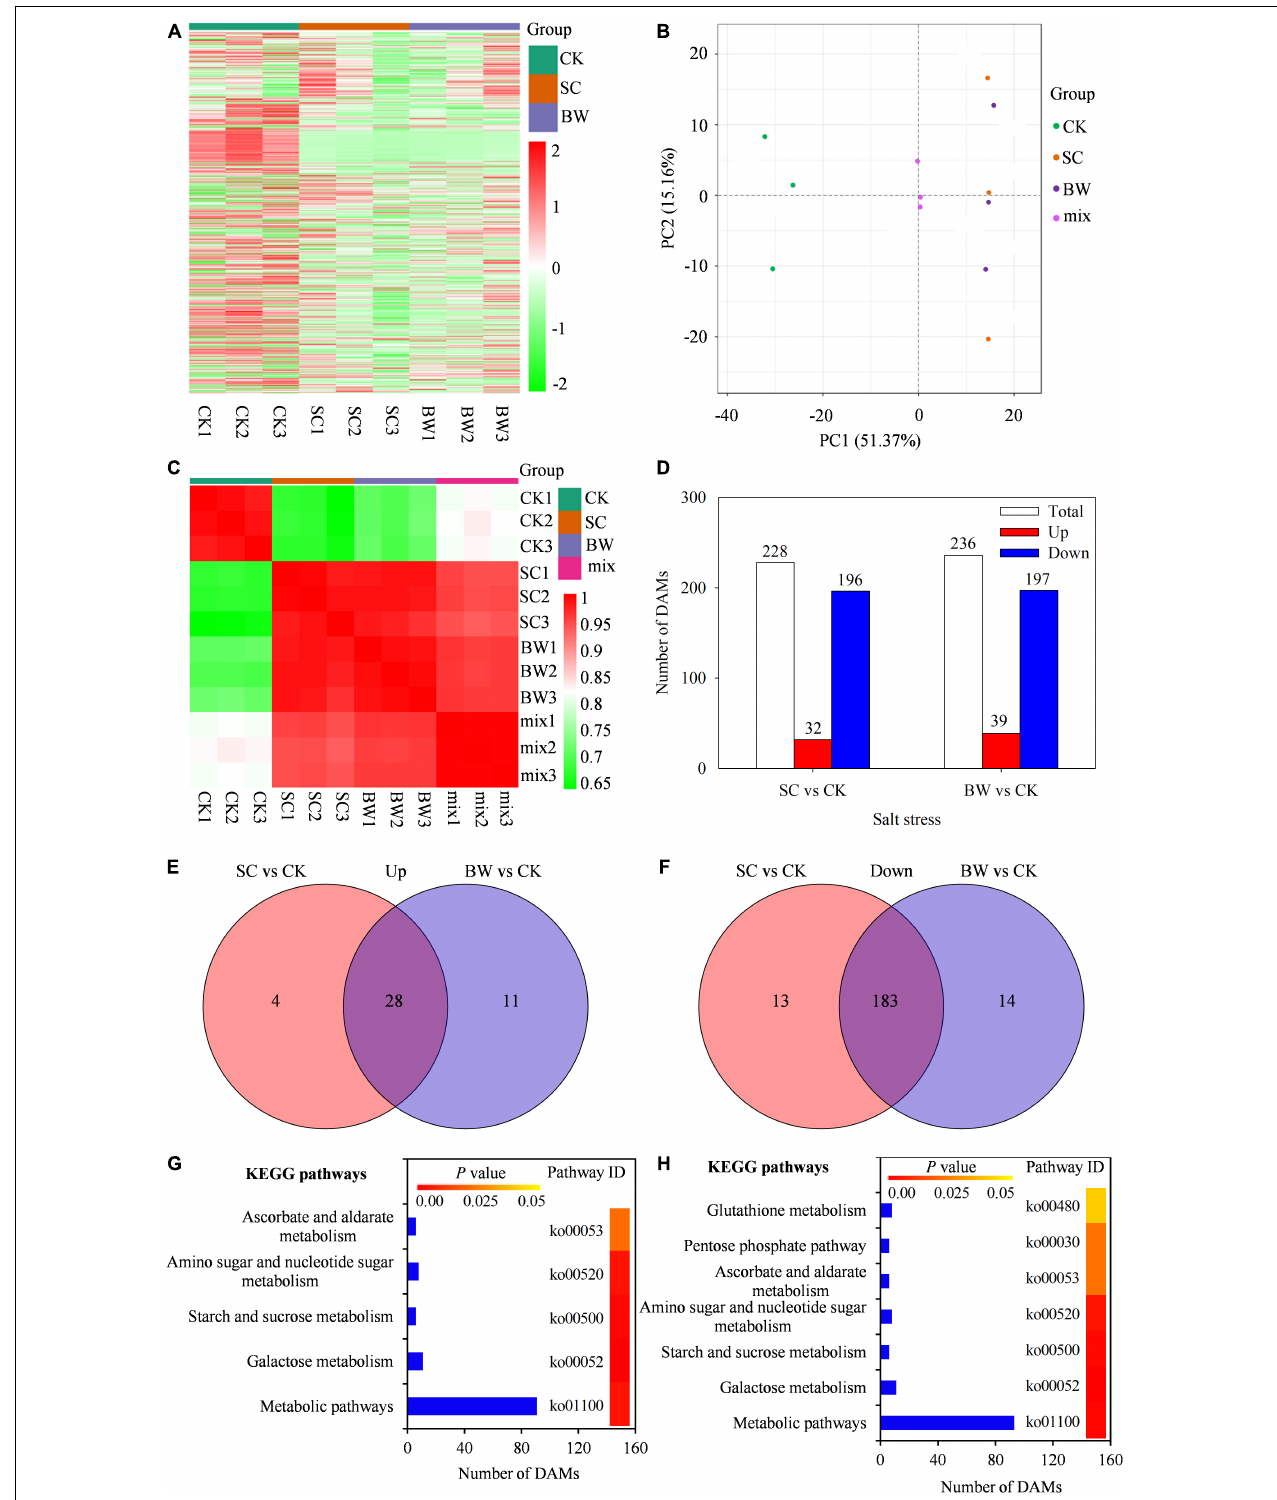
FIGURE 4 | The metabolites analysis in quinoa during the seed initial imbibition under salt stress. (A) Heatmap visualization of total metabolites, (B) Principal Component Analysis (PCA) clustering based on metabolome data, (C) the correlation of samples based on the square of Pearson Correlation Coefficient (R 2 ), (D) number of total, up-accumulated and down-accumulated differentially abundant metabolites (DAMs) with fold change ≥ 2, venn diagram of (E) up-accumulated and (F) down-accumulated DAMs, significantly enriched KEGG pathways of DAMs in (G) SC vs. CK and (H) BW vs. CK.